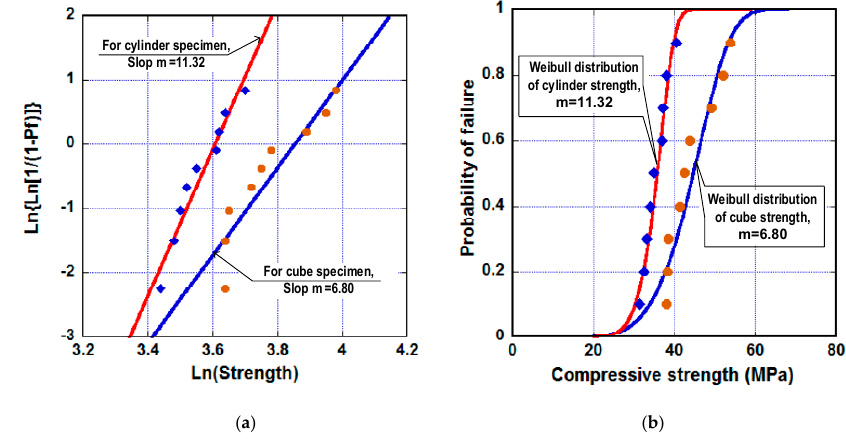
Figure 11. Applying Weibull’s size effect law to the steel-slag concrete. ( a ) Attaining Weibull modulus. ( b ) Weibull distribution of the compressive strength.